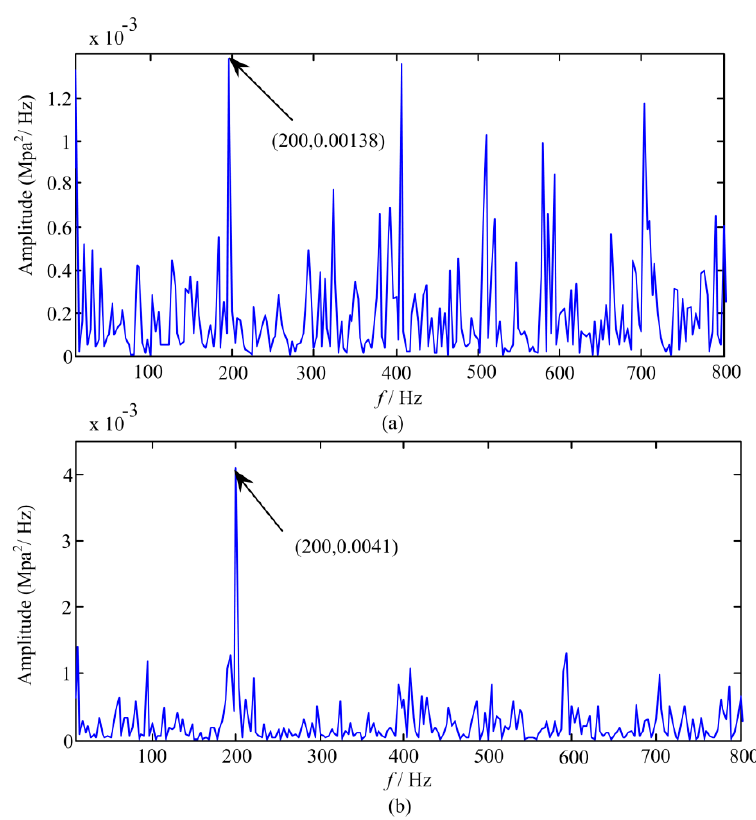
Figure 5. Power spectra of pressures signals obtained from ( a ) data set 758 and ( b ) data set 759.